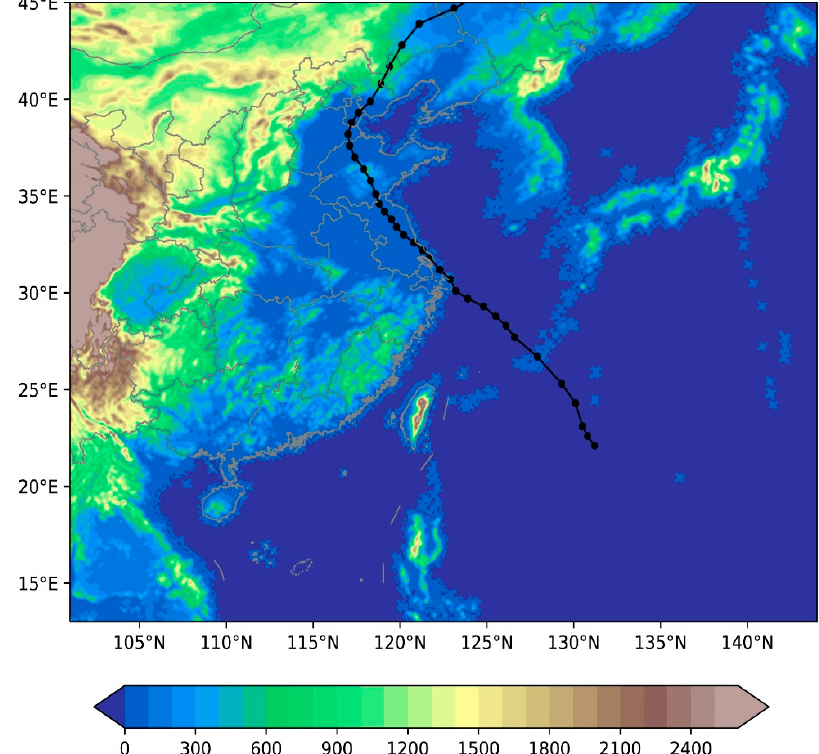
Figure 2. The track of Ampil (black dot line) in the model domain overlapped by terrain height (filled colors, unit: m) from 1800 UTC on 19 July 2018 to 0600 UTC on 26 July 2018.